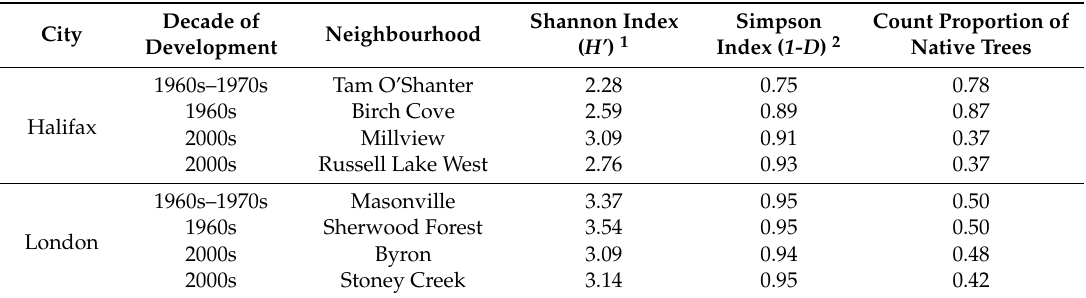
Diversity indices of residential property tree communities combined according to